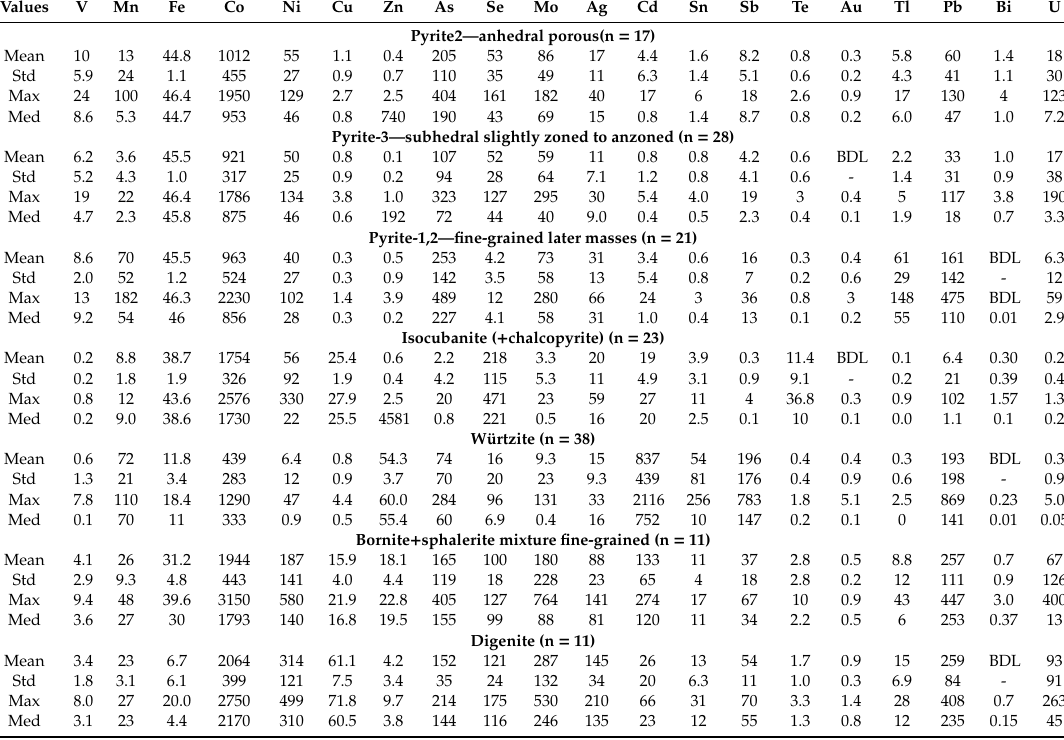
Table 2. Trace element concentration in sulfides of the pyrite-sphalerite-chalcopyrite crusts. Pobeda vent site-3. LA-ICP-MS data in ppm. Fe, Cu, and Zn is in